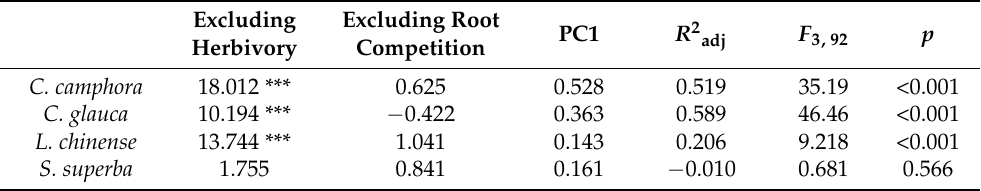
Table 2. Analysis of covariance (ANCOVA) for the four species. The dependent variables were the proportion of surviving seedlings in each plot for each species, the independent variable was a cate- gorical variable indicating treatment (control, excluding herbivory, and excluding root competition), and PC1 was included as a covariate. The significance of the regression coefficients and the adjusted R-squared ( R 2 adj ) values are also presented. Significance level: *** p < 0.001.